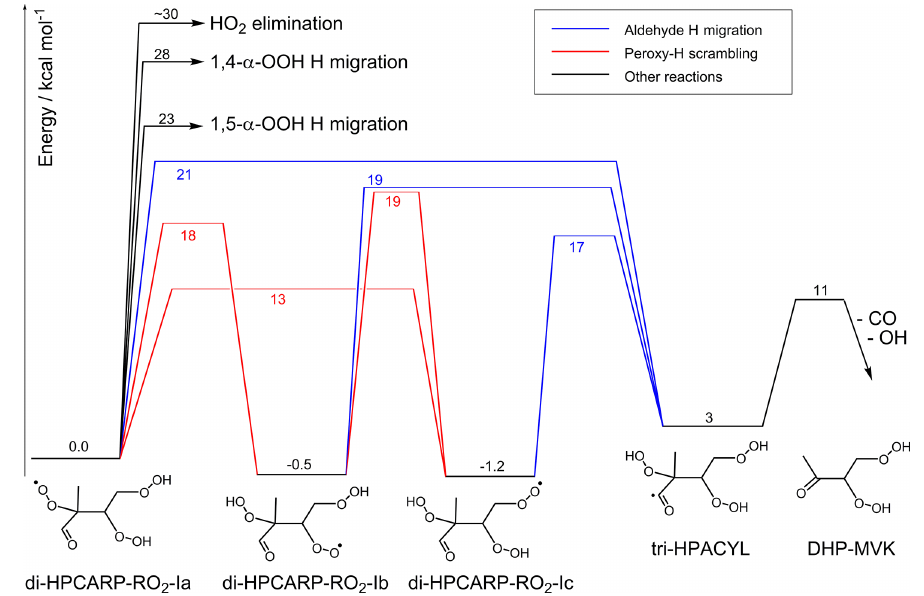
Figure 3. Potential energy surface for the aldehyde-H shift reaction showing the multiple competing reactions. A set of fast H-migration reactions ultimately leads to the formation of a tri-hydroperoxy acyl radical, tri-HPACYL. The main fate of this radical is shown by explicit theoretical calculations to be CO elimination, forming DHP-MVK; O 2 addition to a tri-hydroperoxy acylperoxy radical has only a minor